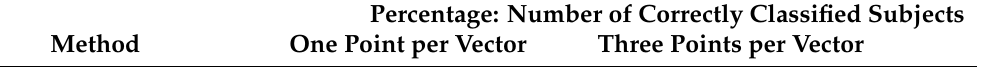
Table 4. The averaged accuracy obtained on the subject level for the four classification methods. The train and test sets defined based on vectors mixed from two sessions. Values of standard deviations are presented in brackets.